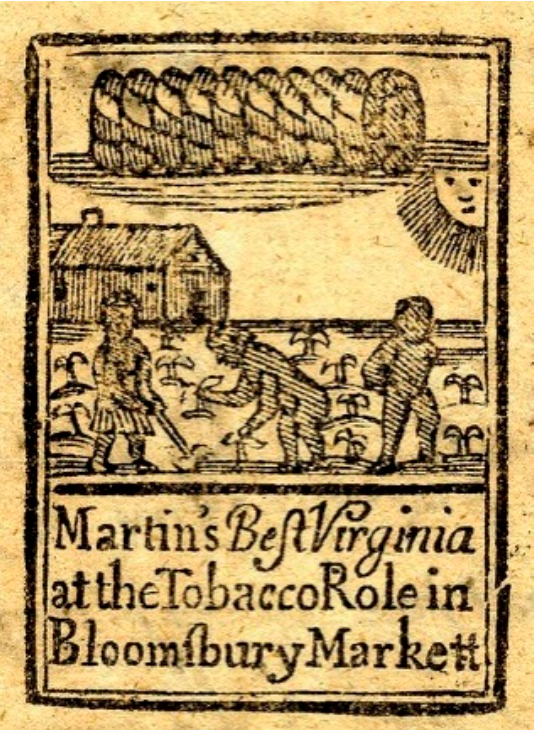
Figure 1. Tobacco paper with advertisement for Martin’s Best Virginia; woodcut, 58 mm × 42 mm (2006, U.390). © The Trustees of the British Museum , London.